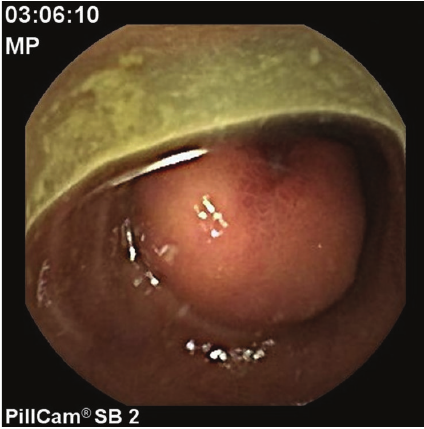
Figure 1: Video capsule endoscopy showing a centrally exulcerated tumor in the ileum.